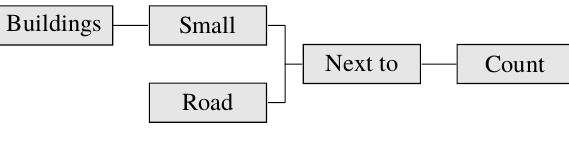
Figure 4. Sample question and corresponding tree